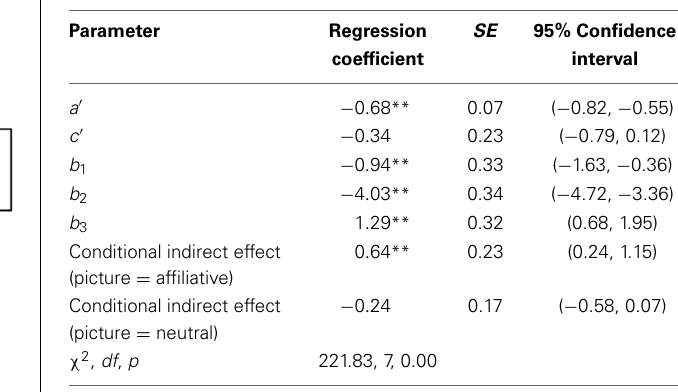
Table 4 | Moderated mediation